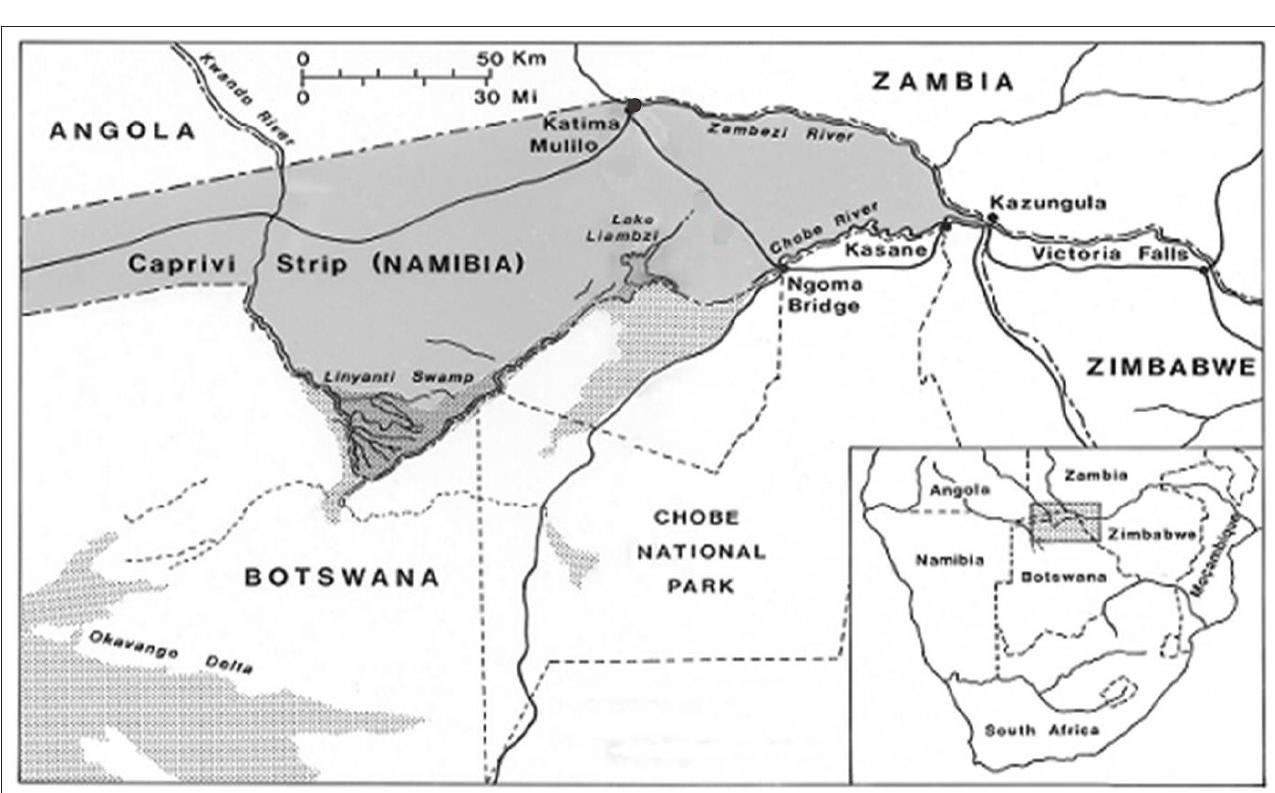
FIGURE 1: Map of area affected by the 2006 epizootic ulcerative syndrome